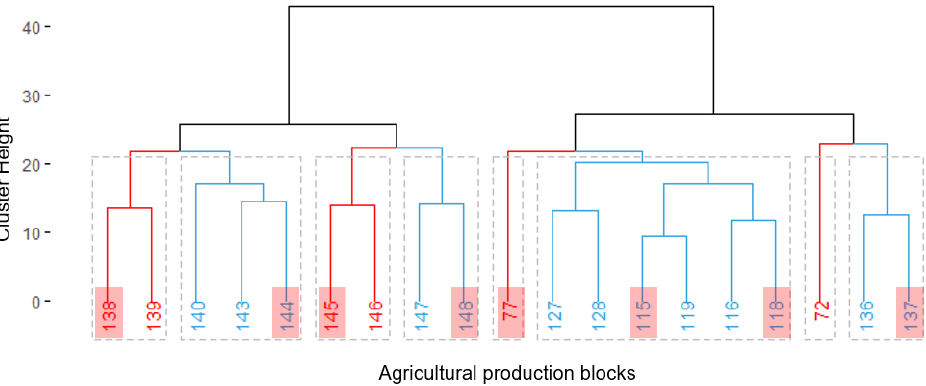
Figure 4. Clusters of the oil palm plantation according to monthly yield. There are eight clusters in total (dotted gray squares), the lines of different colors (red and light blue) separate the clusters, and the APBs selected in each cluster are highlighted in red.